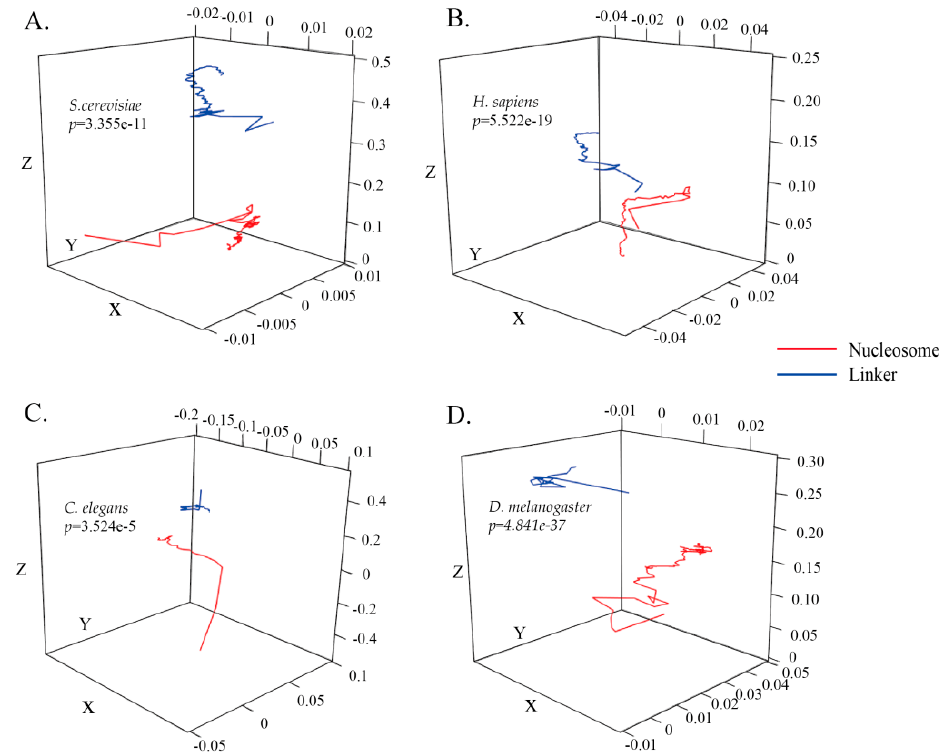
Figure 1. Three-dimensional space imaging of nucleosomal and linker sequences using our model for four species. ( A) , ( B ), ( C ), and ( D ) represent Saccharomyces cerevisiae ( S. cerevisiae ) , Homo sapiens ( H. sapiens ) , Caenorhabditis elegans ( C. elegans ) and Drosophila melanogaster ( D. melanogaster ), respectively. The red curve represents the nucleosomal sequence model and the blue curve represents the linker sequence model.